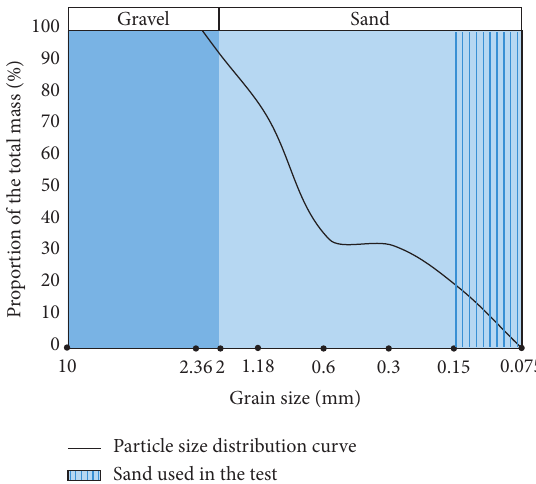
Figure 3: Particle size distribution curve of sand in the